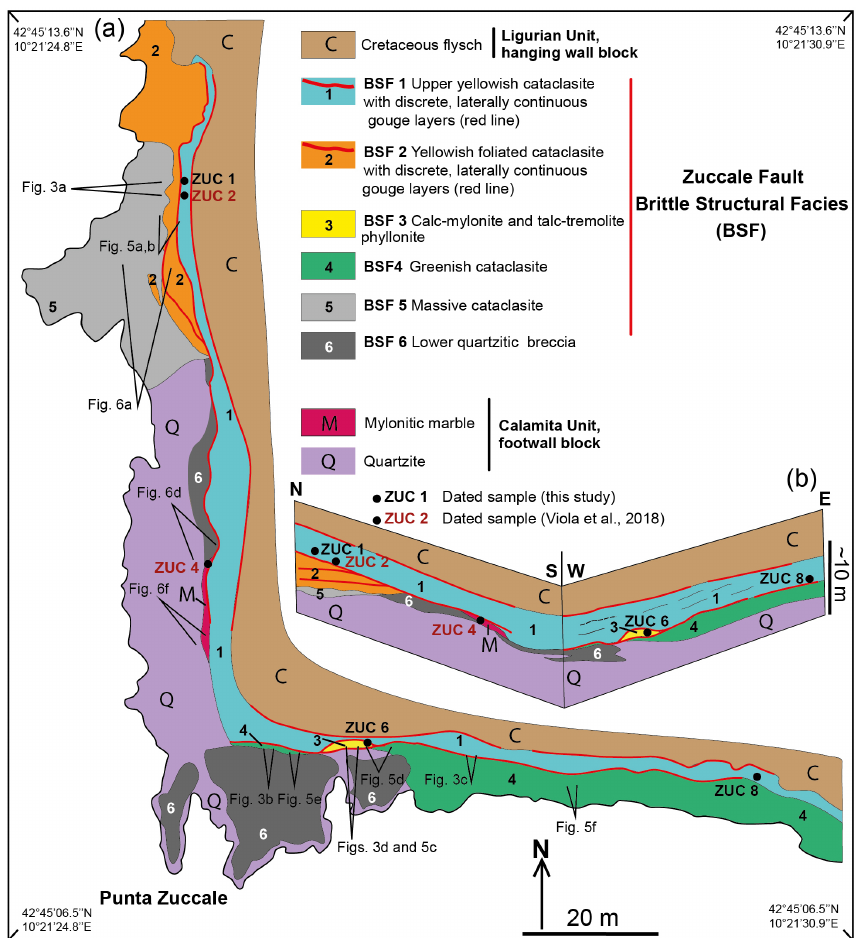
Figure 2. (a) Geological map of Punta Zuccale showing the distribution of the brittle structural facies (BSF) of the ZF and the location and name of the samples dated in this study (in black) and in Viola et al. (2018; in red). The location and direction of view of the photographs in Figs. 3, 5, and 6 are shown. (b) Fence diagram illustrating fault rock distribution along the N–S and E–W natural cross sections that are directly accessible along the shoreline of Punta